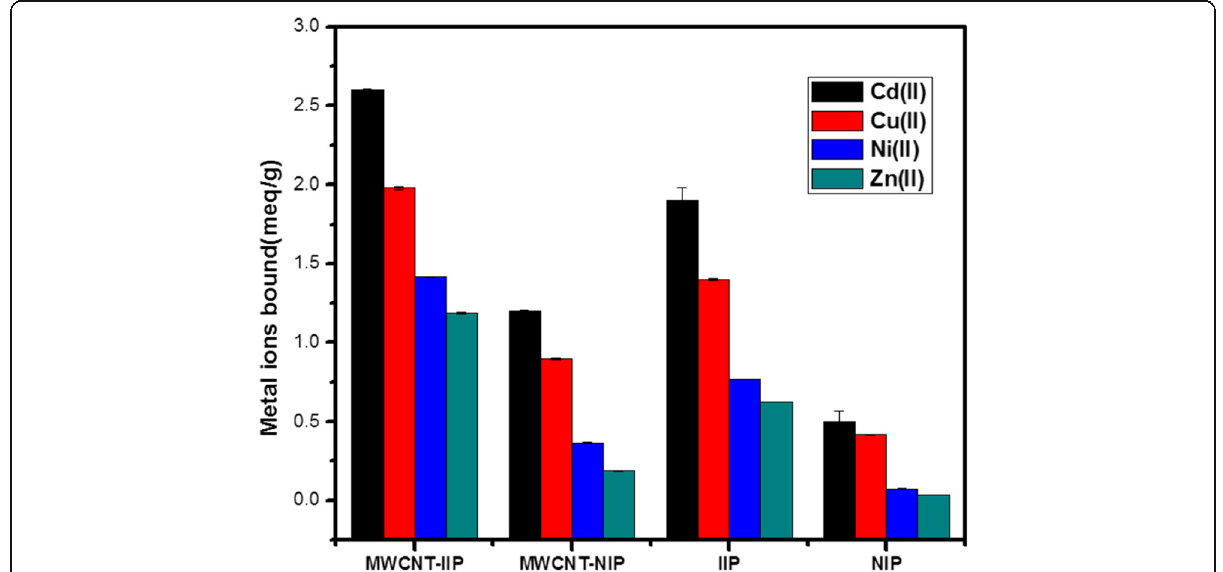
Fig. 19 Selectivity of Cd(II) ion-imprinted polymer and non-imprinted